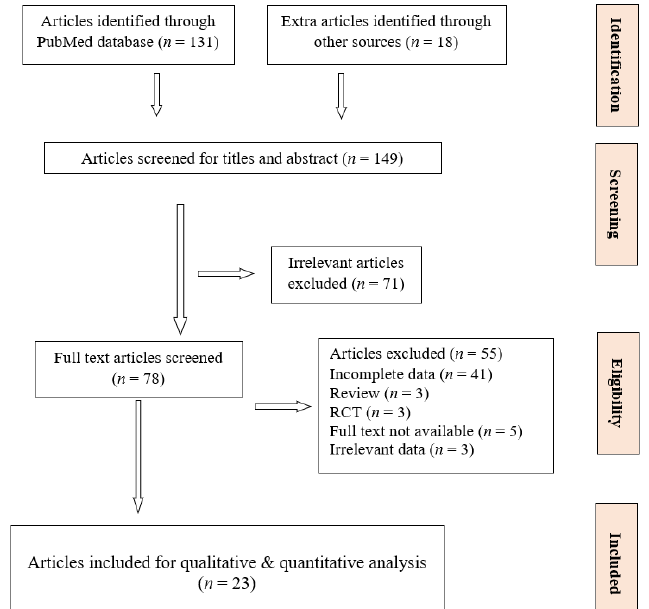
Figure 1. Systematic review PRISMA flowchart of research articles screened, excluded and included in meta-analysis. PRISMA: Preferred Reporting Items for Systematic Reviews and Meta-Analyses; RCT: randomized controlled